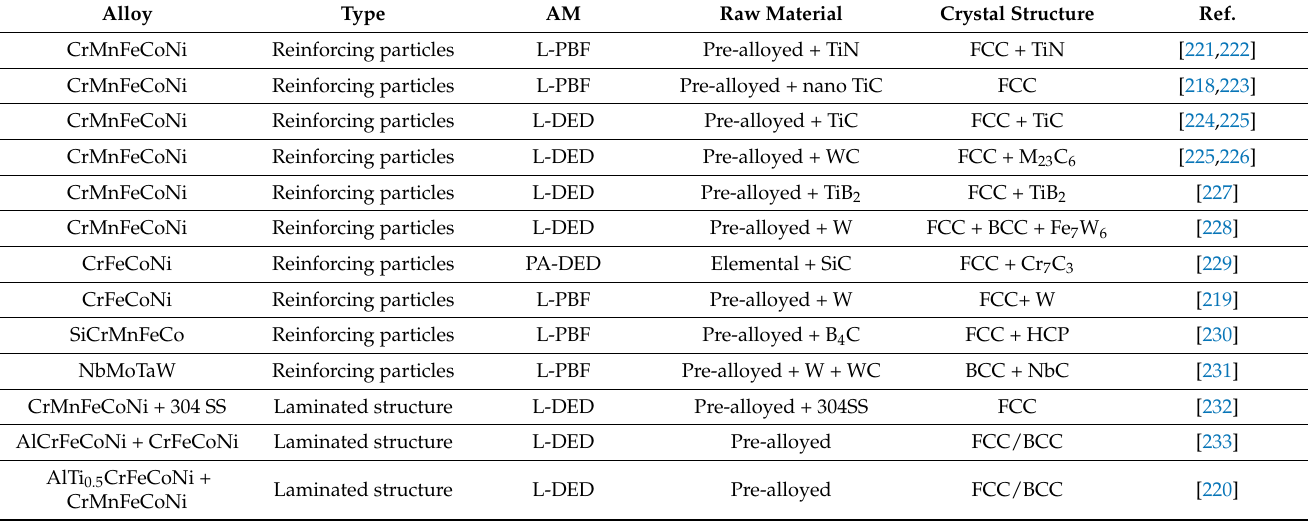
Table 9. Composite materials with HEA